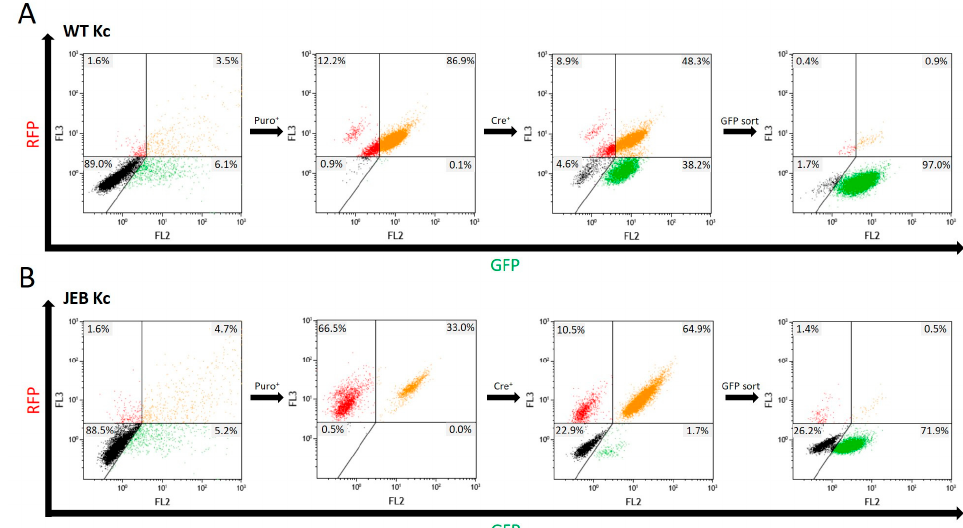
Figure 2. Flow cytometric analyses during GFP-C17 cell line generation. Following treatment of wild-type keratinocytes ( A ) and JEB keratinocytes ( B ), transfected cells transiently expressed RFP and GFP from the HR template and the Cas9/sgRNA-expressing plasmid, respectively. Subsequent puromycin selection led to the accumulation of RFP- or RFP/GFP-expressing cells. Cre-recombinase-mediated deletion of the selection cassette brings the GFP-C17 expression under the control of the endogenous COL17A1 promoter resulting in a cell population exclusively emitting green fluorescence (~38% of WT Kc and ~1.7% of JEB Kc). A subsequent GFP pos sort via FACS significantly